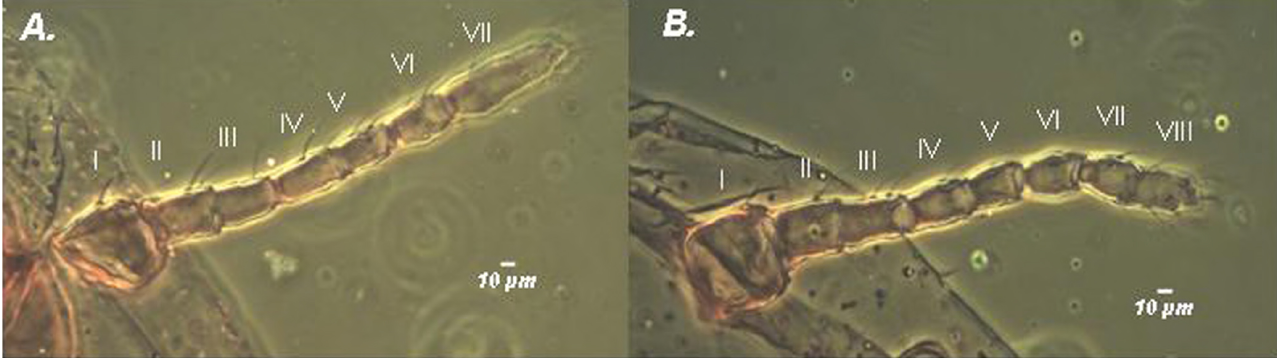
Figure 2. Nipaecoccus coffeae : 7-segments antenna (A); antenna apparently with 8 segments (B).